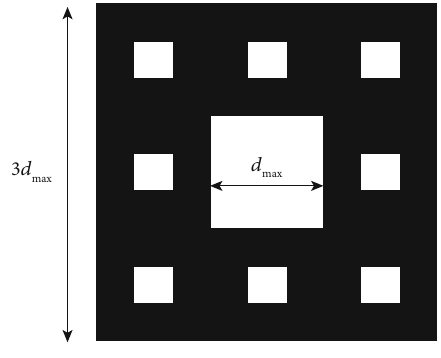
Figure 3: Schematic diagram of